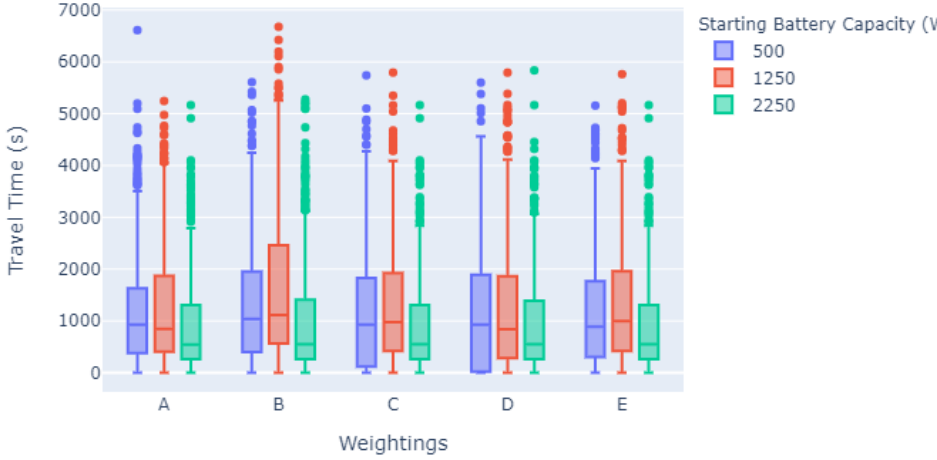
Figure 8. The achieved travel time under varying weightings: the case of the Manchester road network.